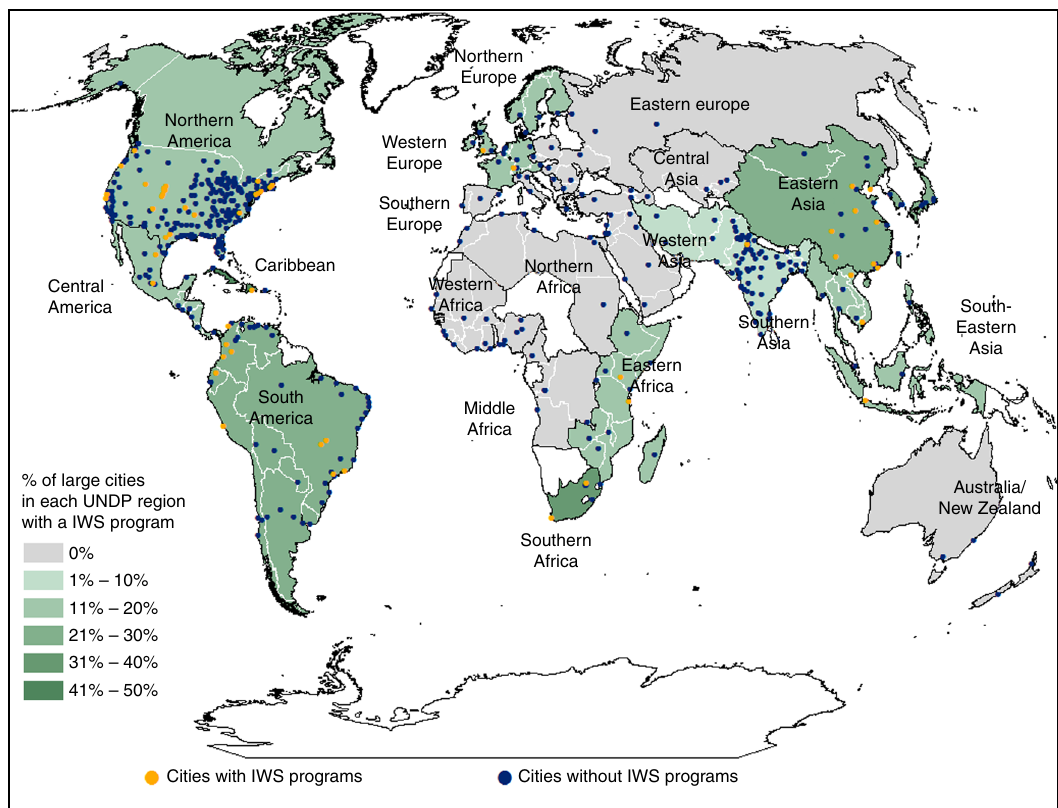
Fig. 2 Percentage of large cities within each UNPD region that had an IWS program. Gray countries had no documented IWS programs and white countries had no cities large enough to qualify for inclusion in the CWM database. The remaining regions are shaded from the highest proportion of CWM cities with IWS (50%, dark green), to the lowest proportion of CWM cities with IWS ( < 10%, light green)